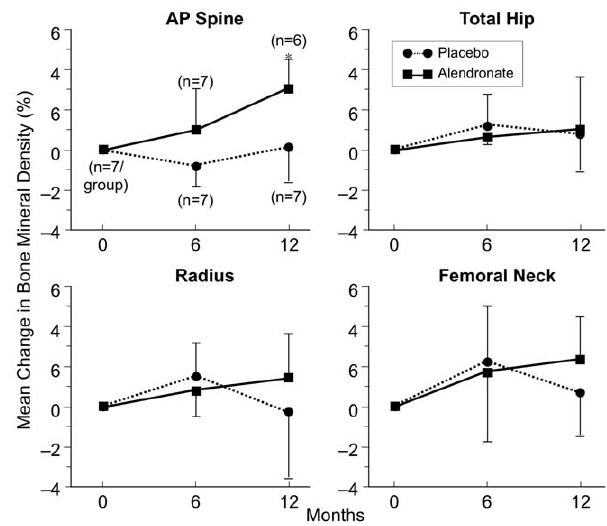
Figure 3. Bone mineral density measurements in women with MDD and moderate osteopenia or osteoporosis randomized to alendronate vs. placebo. Over 12 months, the Alendronate group showed a significant increase in BMD at the lumbar spine (P=0.003), and there was a trend for increased BMD at the femoral neck (P=0.06). No changes over time were observed in the Placebo group.